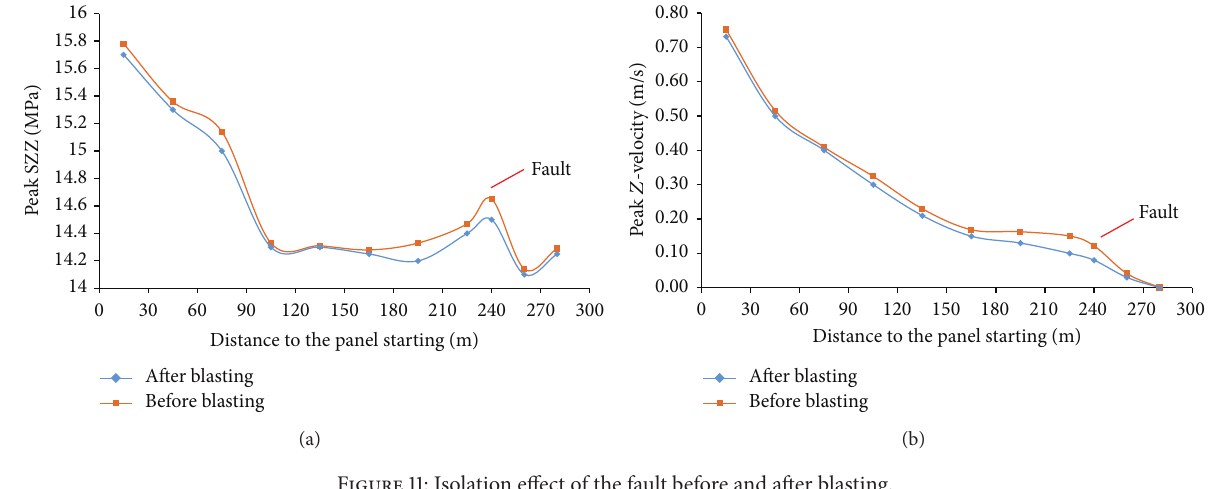
Figure 11: Isolation effect of the fault before and after